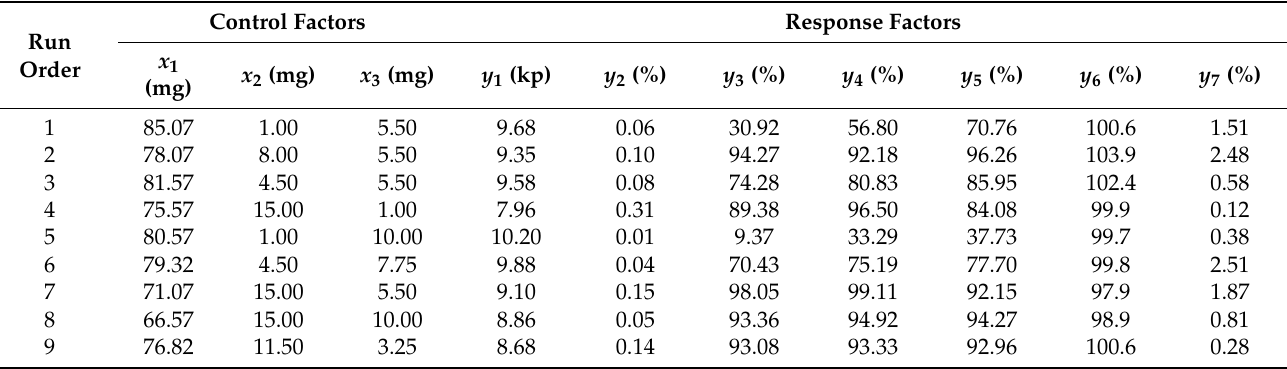
Table 1. The result of the experiment design and summary of the coded equation and statistical